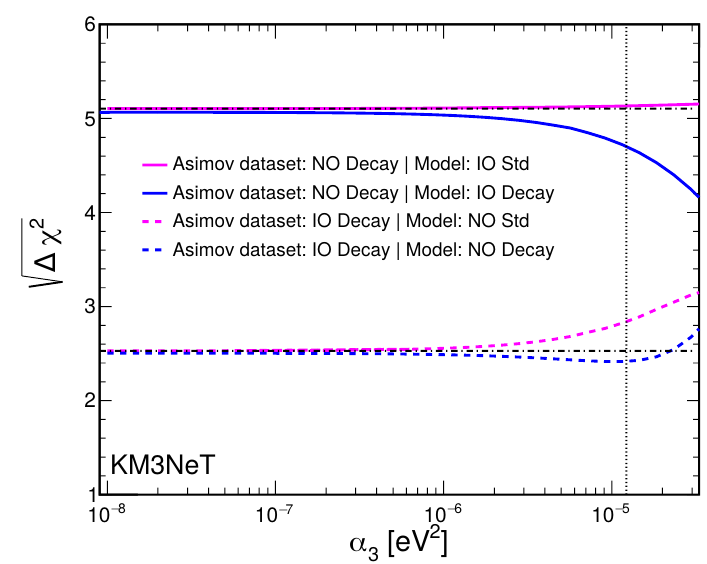
Figure 14. NMO sensitivity assuming true NO (solid) and true IO (dashed) for 3 years of data taking as a function of the true value of α 3 . Two cases are considered: decay scenario in both the Asimov dataset and the model (blue) and decay scenario in the Asimov dataset, but assuming standard oscillations in the model (magenta). Horizontal lines correspond to the expected sensitivities when no invisible neutrino decay occurs. The vertical line corresponds to α 3 = 1 . 22 × 10 − 5 eV 2 (current best limit from the combination of SK+K2K+MINOS at 3 σ CL [17]). the standard oscillation scenario. Only large values of α , currently strongly disfavoured by 3 experimental results, could impact the sensitivity to